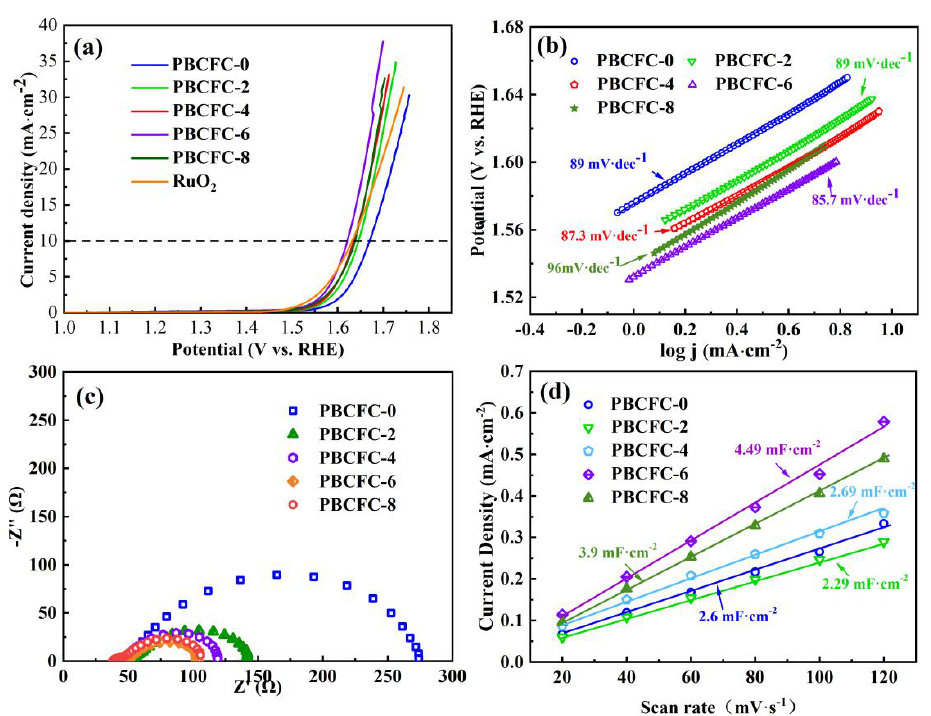
Figure 4. OER polarization profiles (1600 rpm) of PBCFC-x (x = 0, 2, 4, 6, 8) perovskites ( a ); The Tafel slope derived from the OER plots ( b ); The EIS at 0.6 V vs. SCE ( c ); The function of different scan rates and the current densities at 0.25 V vs. SCE for the PBCFC-x (x = 0, 2, 4, 6, 8) materials ( d